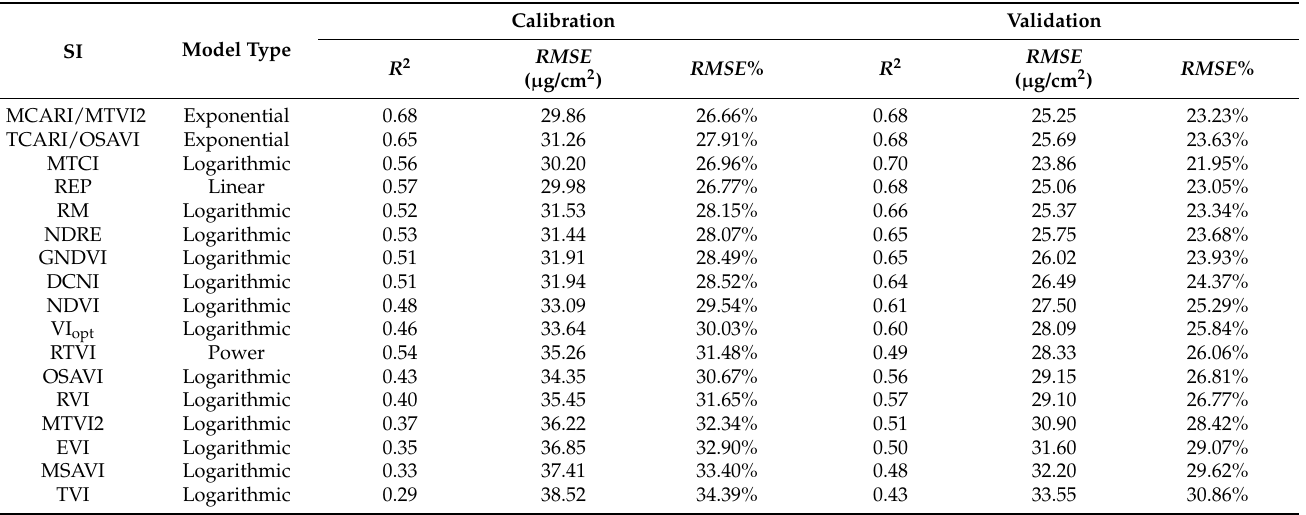
Table 4. LNC prediction results for the models designed using different spectral indices. Linear, logarithmic, exponential and power models were used for fitting each index. The model type with the best results is expressed in the table.